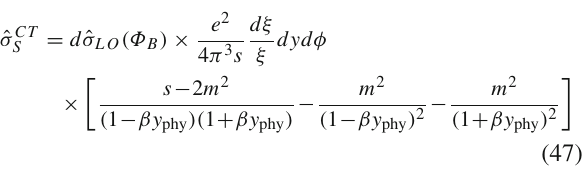
Fig. 5 NLO EW correction as a function of r cut for the complete Drell–Yan process in the dominant qq diagonal channel without cuts (left panel) and with asymmetric cuts (right panel) at 7TeV. The stan- dard result obtained with q T subtraction (grey band) is compared with